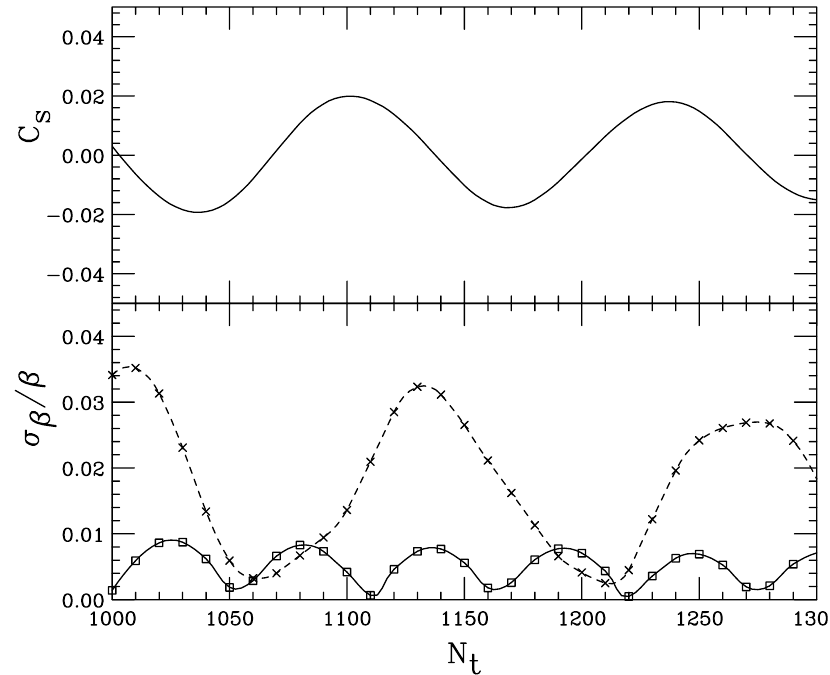
FIG. 5. Effect of number of the sampled turns ( N ) in the LC model with (cid:30) (cid:4) (cid:3) 6 : 7447 and (cid:30) (cid:15) (cid:3) 6 : 7372 . Top: off-diagonal elements t (cid:1) 1 ; 3 (cid:2) . Bottom: ) =(cid:23) vs N for ICA (solid) and PCA of source signals C s (cid:23) t